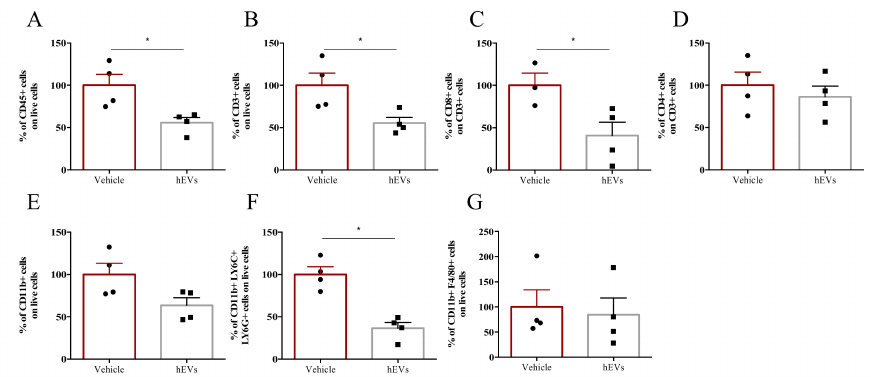
Figure 3. EVsdampenliverinflammationassociatedtoPSC.Liver-infiltratingimmunecellsinFVB.Mdr2 − / −